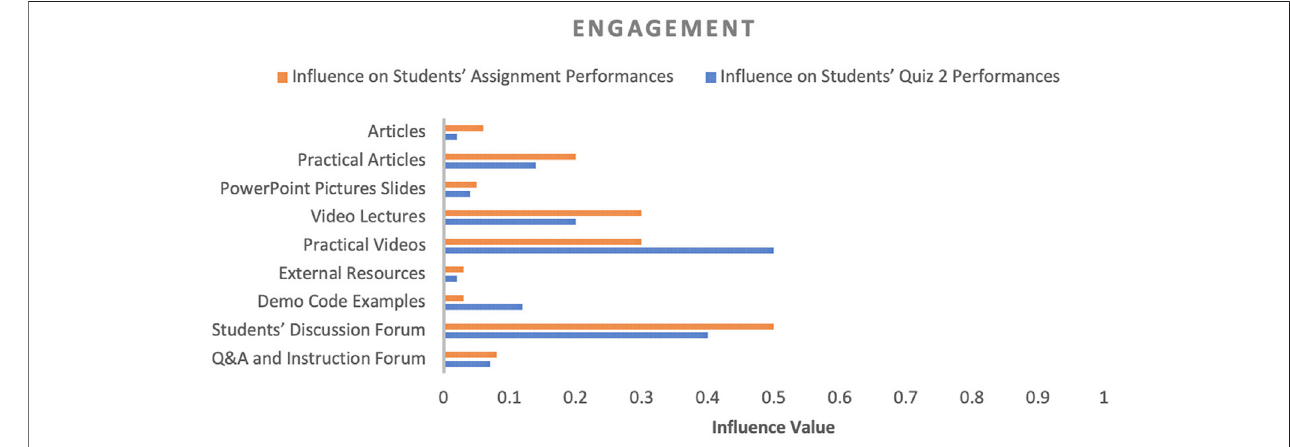
FIGURE 4 | In fl uence of engagement-related factors on students ’ performance.